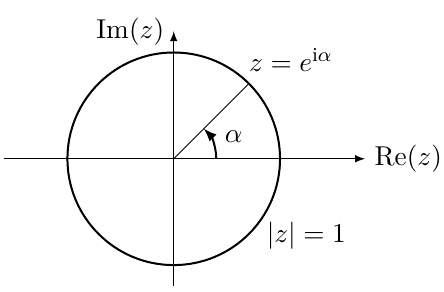
Figure 5 . The contour of integration in the z -plane for the integral (3.27). The angle α is related to z as z = e i α